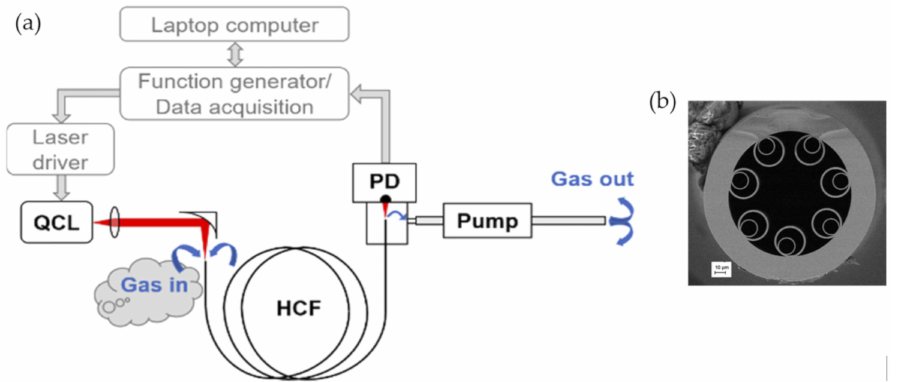
Figure 16. ( a ) Experimental setup of the nitrous oxide detection based on the laser absorption spectroscopy. QCL: quantum cascade laser; PD: photodetector; HCF: HC-ARF. ( b ) Cross-section of the HC-ARF with nested capillaries obtained with SEM